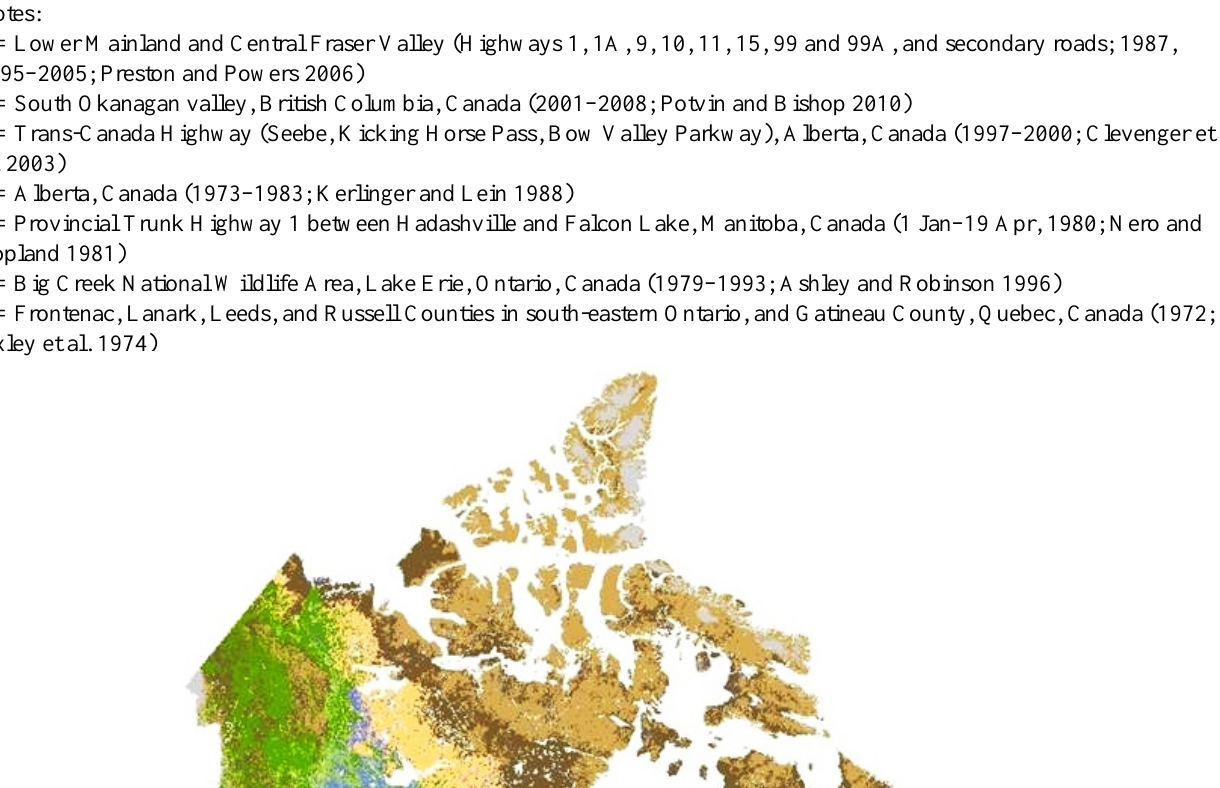
Fig. 1 . Canada’s land cover including wetlands†, geographic range for Barn owls ( Tyto alba ) in British Columbia, Canada, and locations of sites where studies of avian mortality attributed to vehicle collisions have been conducted in Canada. † Natural Resources Canada 2012 a ,